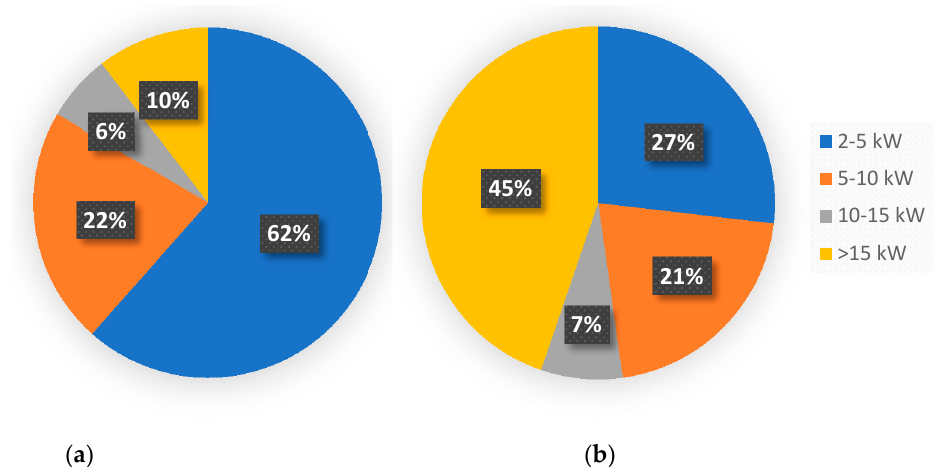
Figure 6. Distribution of the total number of sites with power potential over 2 kW ( a ) and total energy estimations ( b ) between the pre-defined ranges of plant power sizes.